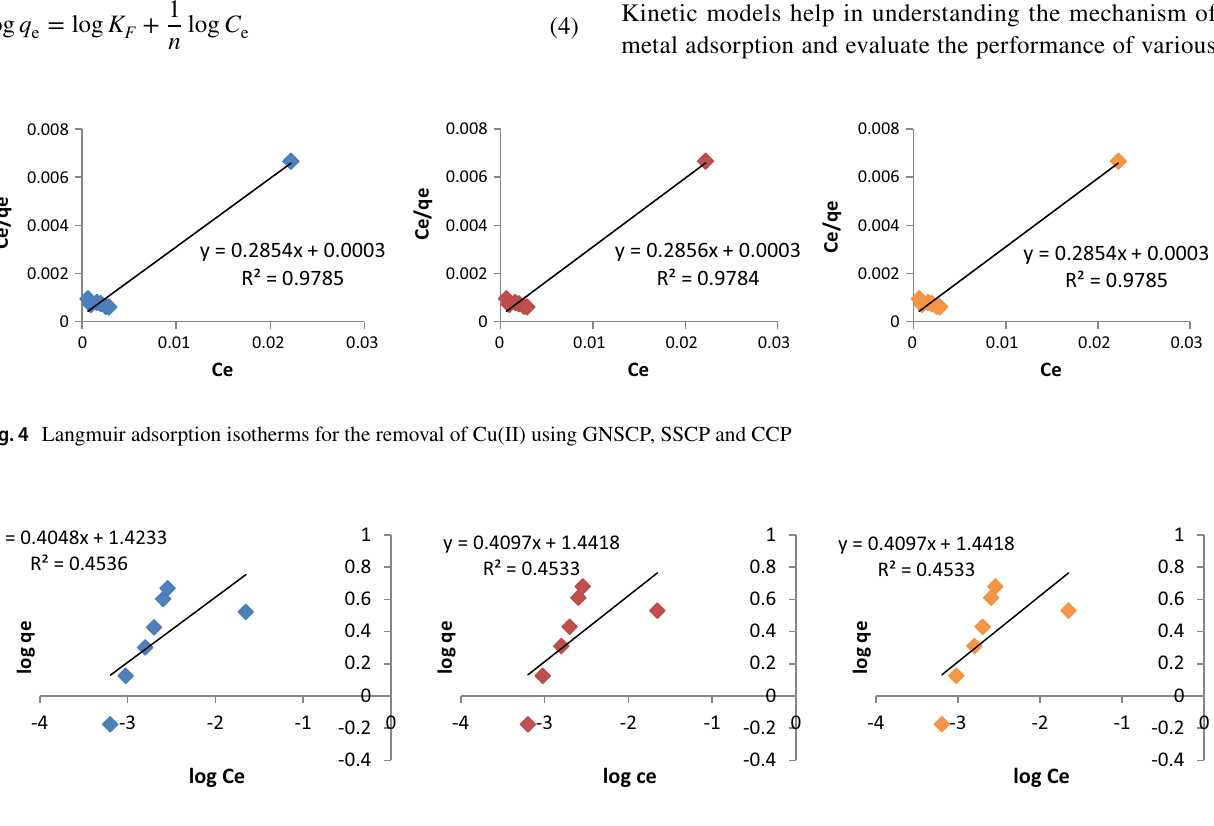
Fig. 5 Freundlich adsorption isotherms for the removal of Cu(II) using GNSCP, SSCP and